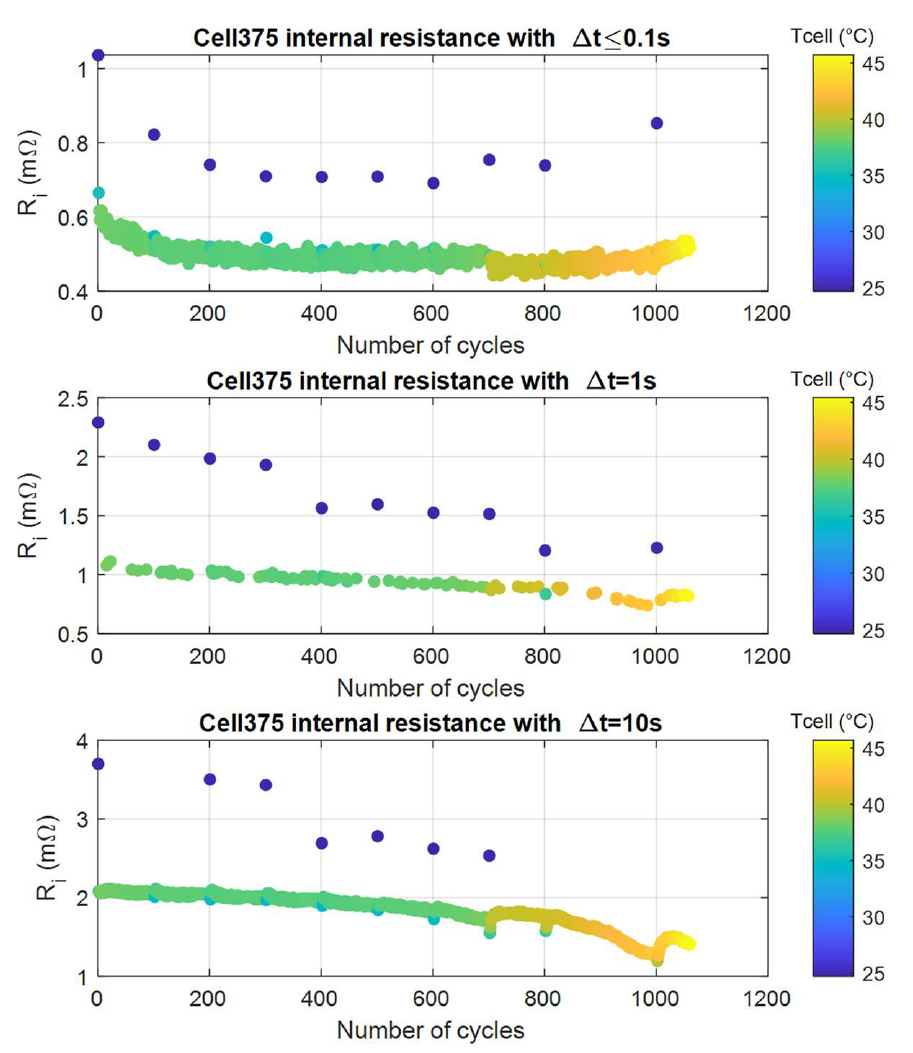
Figure 7. Trend of the start-of-discharge internal resistance for cell375 at SOC = 100% as a function of the number of cycles and cell case temperature for different Δ𝑡 intervals.